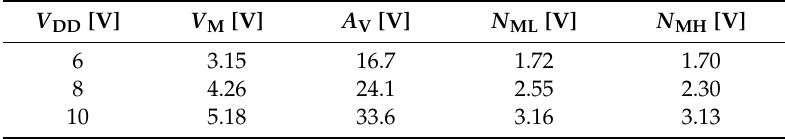
Figure 5. ( a ) voltage transfer characteristics and ( b ) static DC gain of the vertically stacked complementary inverter with p-channel SnO TFT ( W n / L n = 400 µ m / 1000 µ m) fabricated on top of the Table 1. Performance of the vertically stacked complementary inverter at different V DD s.